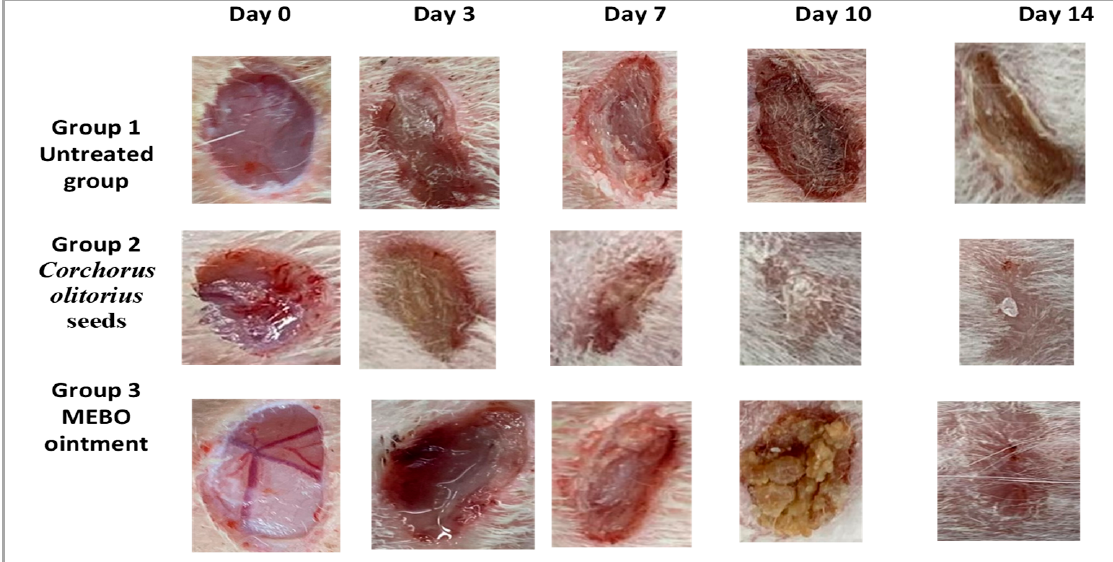
Figure 3. The activity of Corchorus olitorius seed extract and Mebo on excisional wounds on days 0, 3, 7, 10, and 14 post-wounding in the wound of adult male New Zealand Dutch strain albino rabbits, group 1: untreated (bare group), group 2: Corchorus olitorius seed extract-treated group and group 3: Mebo-treated group as a positive control group.